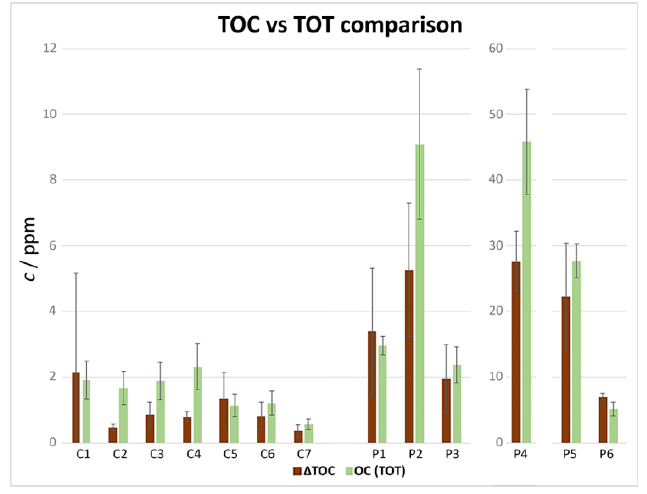
Figure 12. Comparison of TOC and TOT